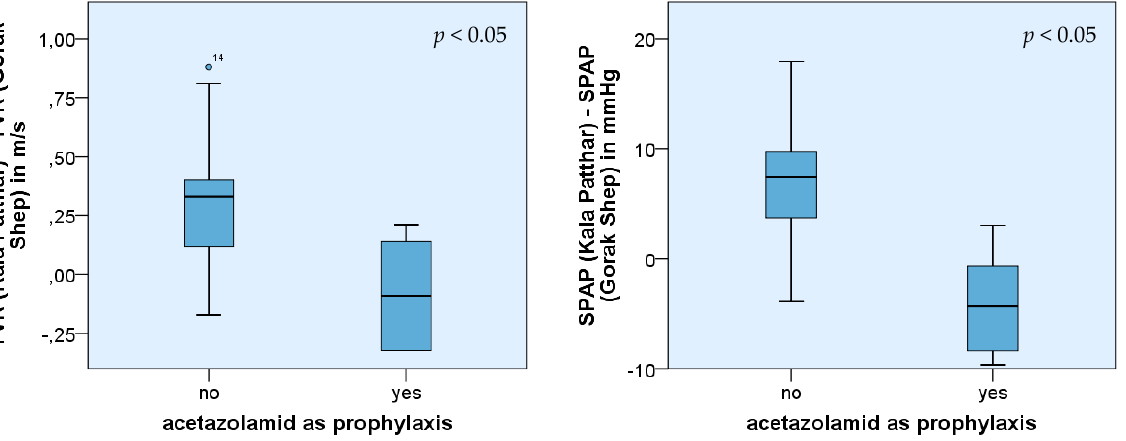
Figure 5. Comparison of mean values of TVR and SPAP after ascent from Gorak Shep to Kala Patthar of two subgroups: subgroup 1 with acetazolamide as prophylaxis ( n = 4), subgroup 2 without intake of acetazolamide ( n =